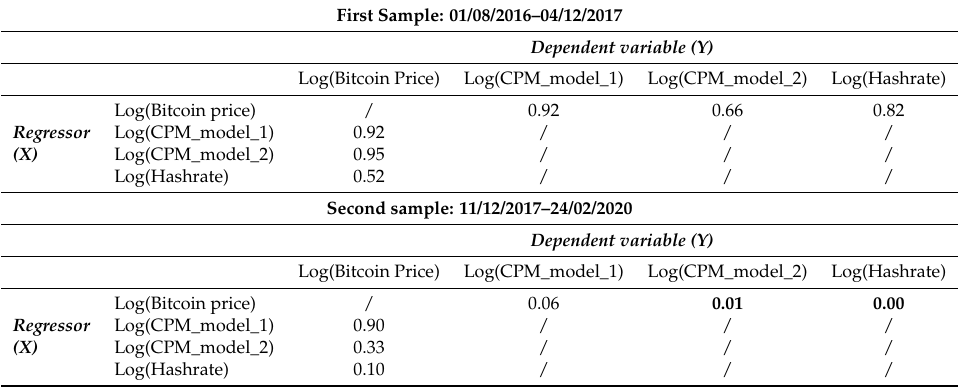
Table 3. p -values for the Granger causality tests using the Toda and Yamamoto (1995) approach. The tests for the CPM(model 1)-CPM(model 2), CPM(model 1)-Hashrate, and CPM(model 2)-Hashrate pairs were not computed for obvious reasons, given how the CPMs are constructed. p -values smaller than 0.05 are in bold font.